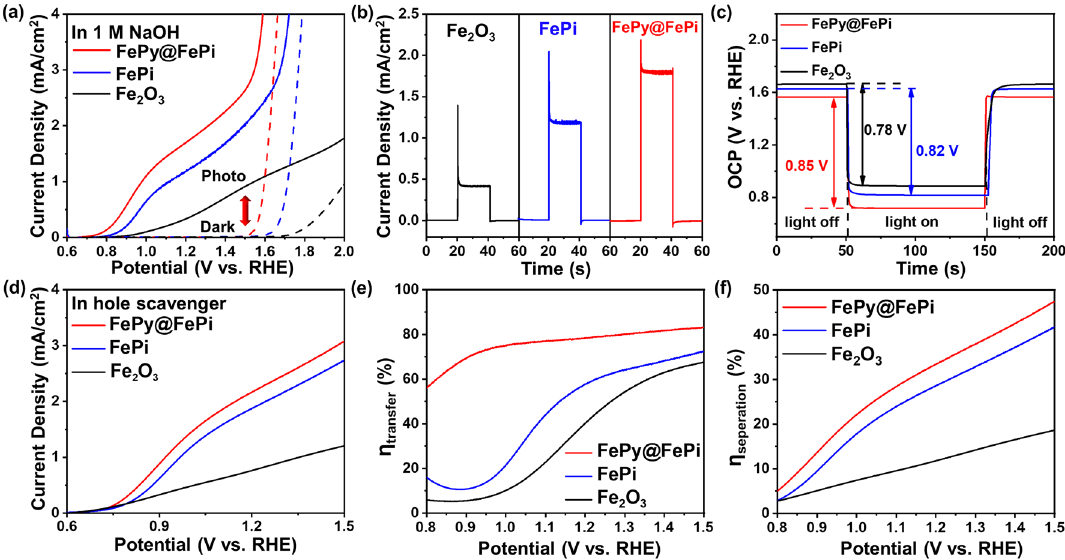
Fig. 5 PEC performance of as‑synthesized samples. a Current density versus potential RHE ( J-V) curves under dark and 1 sun illumination in 1 M NaOH electrolyte. b Chopped current density versus time (J-t) curves of Fe 2 O 3 , and FePi, FePy@FePi decorated photoanodes under dark and 1 sun illumination conditions in 1 M NaOH electrolyte at 1.23 V versus RHE. c Open circuit potential curves under chopped light. d J-V curves measured with the hole scavenger. e Charge transfer efficiency ( η transfer ). f Charge separation efficiency ( ηs eparation ) versus RHE curves of fabricated